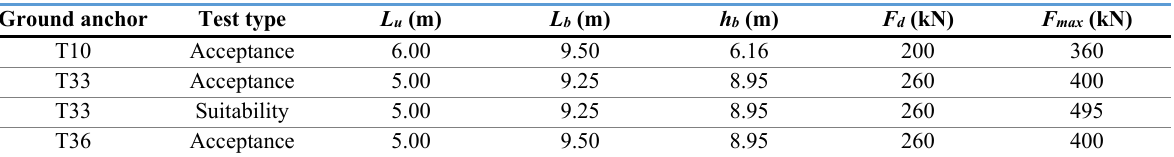
Table 3 - Pullout test